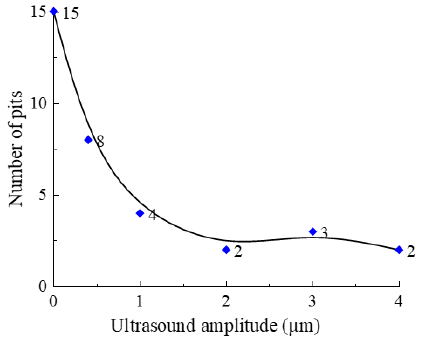
Figure 4. 3D topography of SiCp/Al: ( a ) ordinary grinding and ( b ) ultrasonic vibration-assisted grinding.